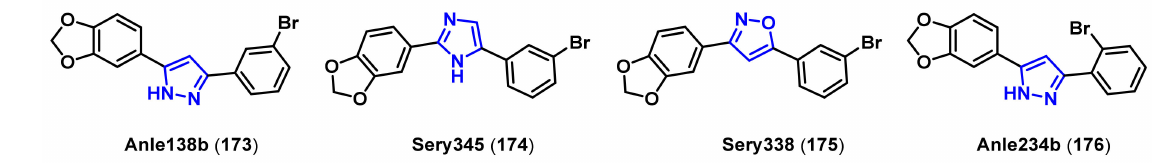
Figure 10. Chemical structures of pyrazole-containing inhibitors targeting